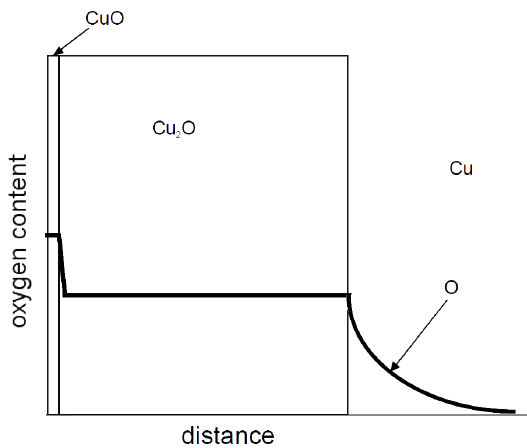
Figure 8. Schematic for the oxygen profile in the Cu plate after oxidation at low